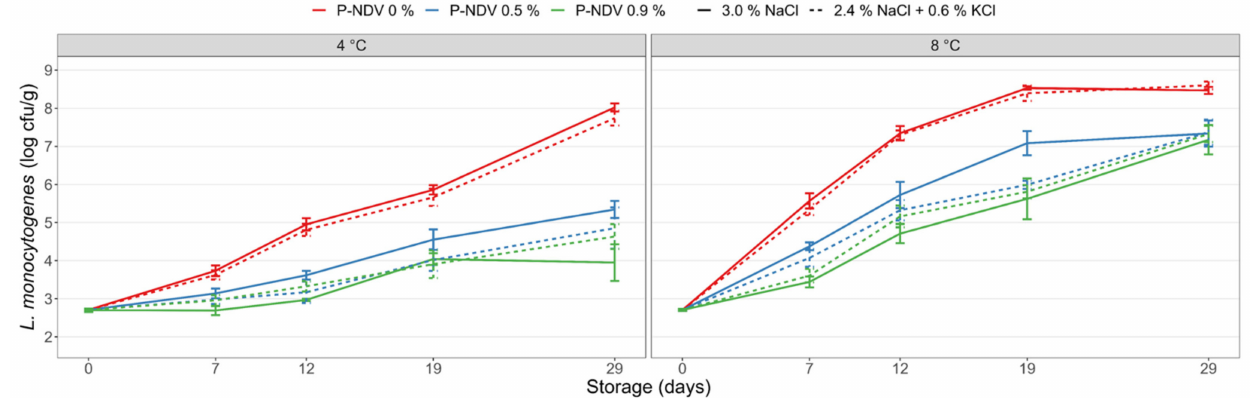
Figure 4. Growth of L. monocytogenes in CS salmon produced with 3% NaCl (control), a sodium- reduced reference salt (2.4% NaCl + 0.6% KCl), and with addition of the preservative salt Provian NDV. The Provian NDV salt was added at levels of 0.5% and 0.9% levels in the salting process. The CS salmon was inoculated with L. monocytogenes at Day 0 and stored under vacuum at 4 ◦ C and 8 ◦ C for 29 days. Mean values of two experiments (four to eight measurements per data point) and standard error of the mean are